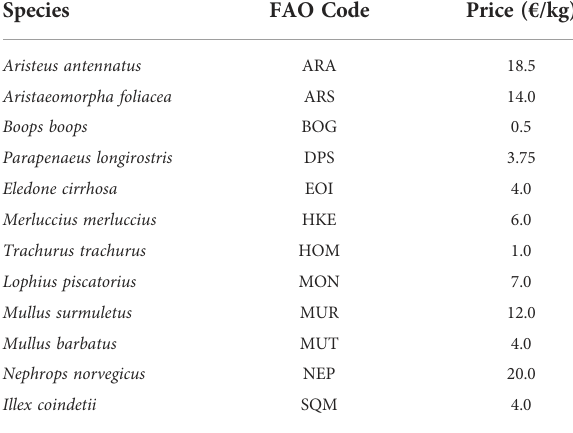
TABLE 1 Mean sales prices for target species indicated by FAO 3alpha code considered in the